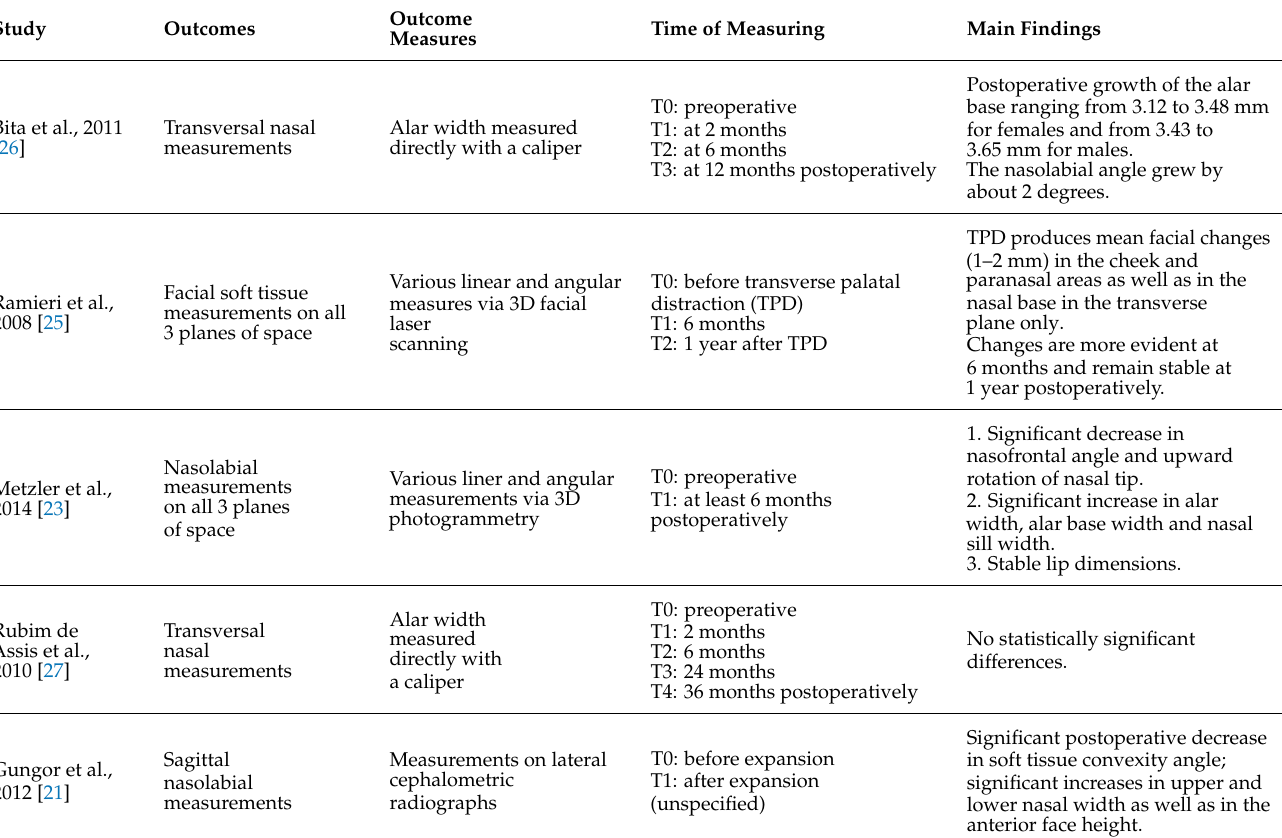
Table 3. Outcomes, outcome measures, time of measuring, and main findings of the included